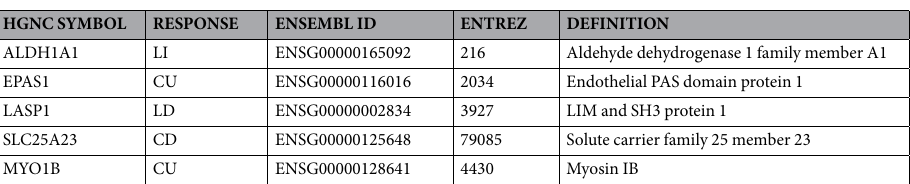
Table 4. Toxicological Transcriptome Core List. Codes for response are: (LD) linear decreasing, (LI) linear increasing, (CD) nonlinear concave down, and (CU) nonlinear concave